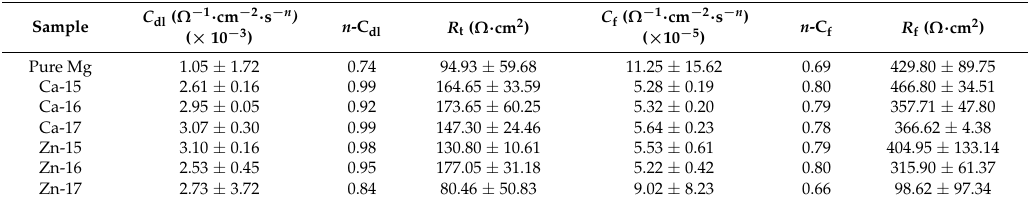
Figure 2. Ca-ion implanted magnesium in SBF: ( a ) Nyquist plot and equivalent circuit; and ( b ) polarisation resistance. Zn-ion implanted magnesium in SBF: ( c ) Nyquist plot and equivalent circuit; and ( d ) polarisation resistance. Table 3. Electrochemical impedance spectroscopy (EIS) results of Ca-ion and Zn-ion implanted magnesium in SBF.